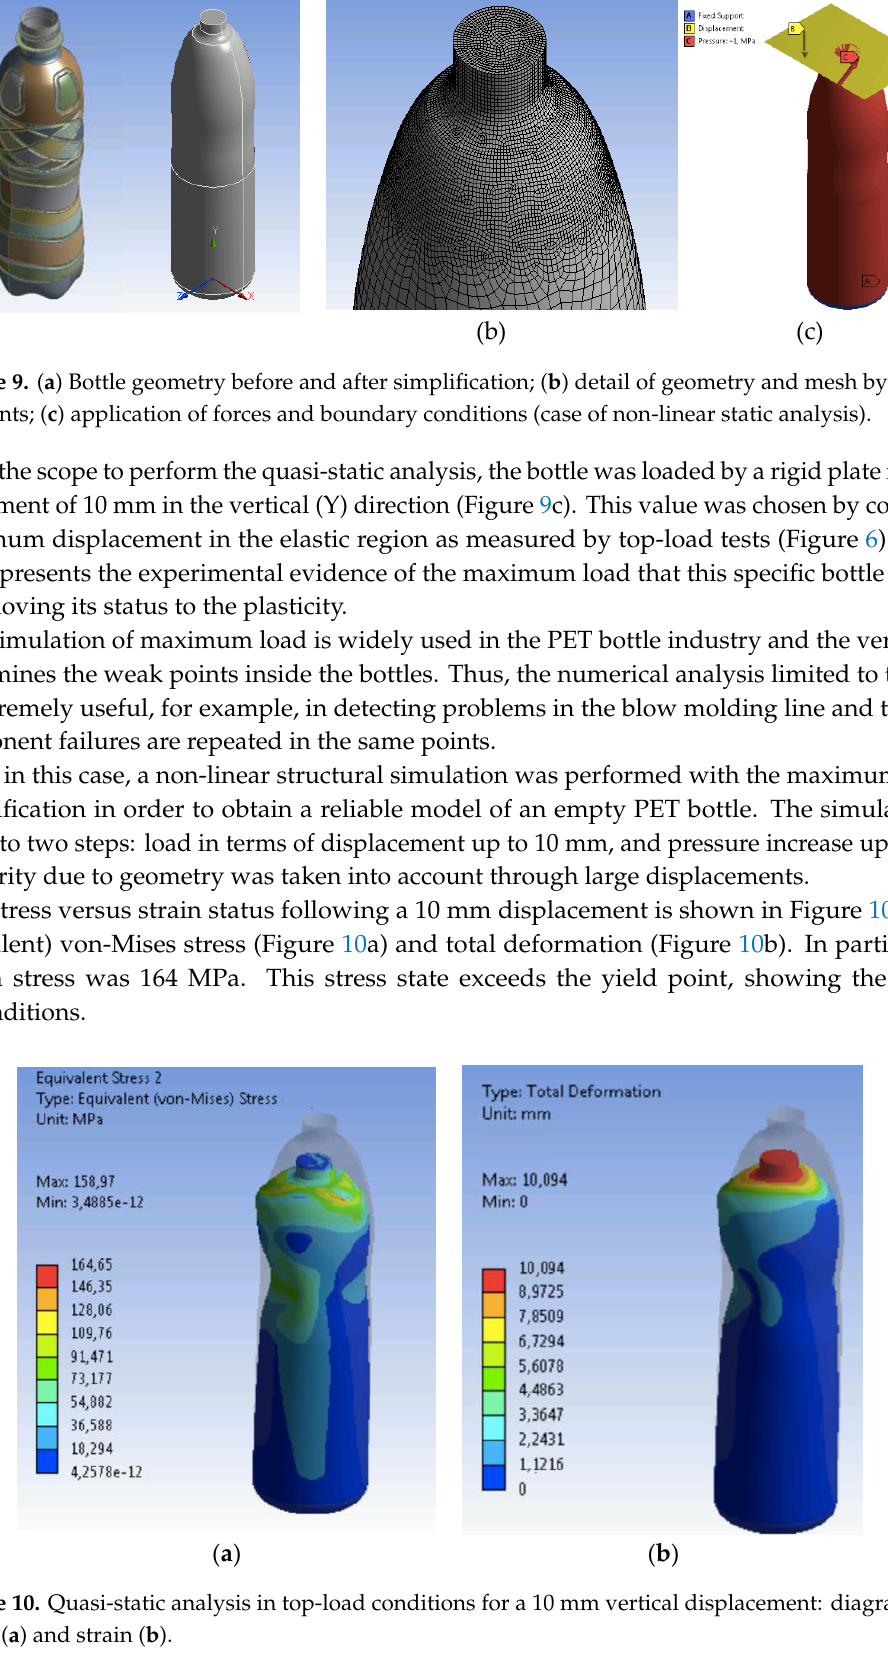
( d ) Figure 11. Buckling analysis in top-load conditions for a 10 mm vertical displacement, limited to the initial four modes of instability and for a load multiplier ( k ) of: ( a ) k = 0.19; ( b ) k = 0.16; ( c ) k = 0.12; ( d ) k = 0.09.